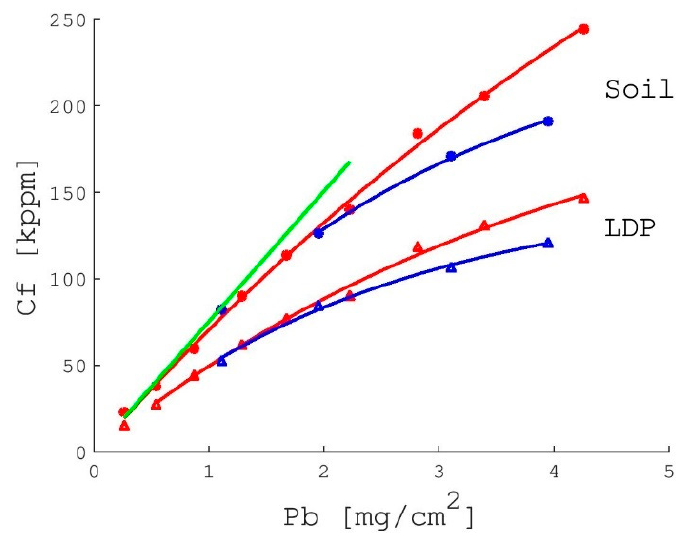
Figure 3. Data from the latex measurements with built ‐ in calibrations for soil ( ● ) and low ‐ density polymers ( δ ) on plasterboard (red) and concrete (blue) substrates. The green line is a tangent for soil calibration at point 0. Table 1. Coefficients of the linear regression and R ‐ square values for four types of calibrations and two types of substrate.